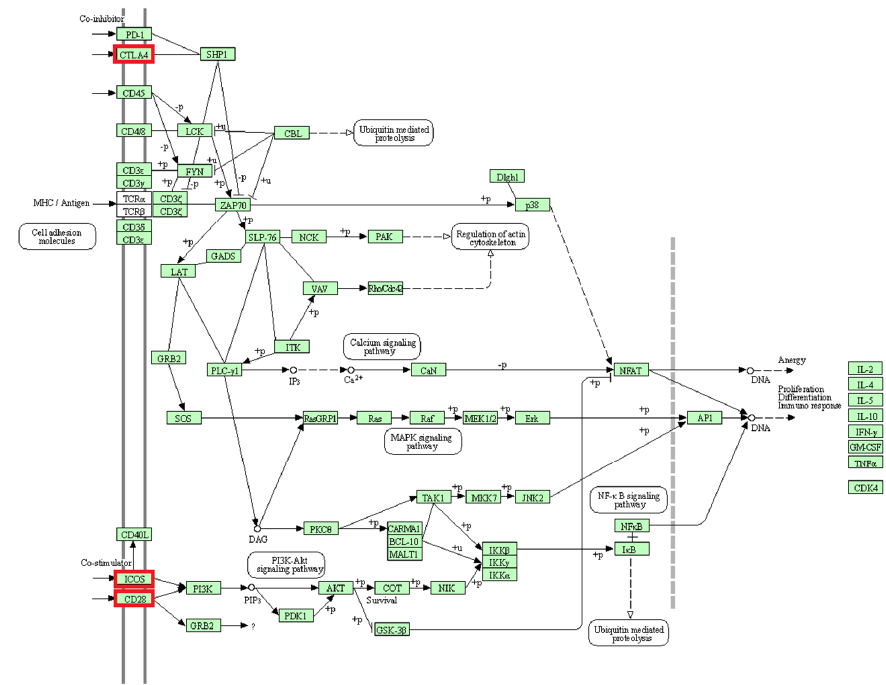
Figure 9. Human T cell receptor signaling pathway (KEGG database [76], hsa04660). The genes belonging to the proteins highlighted in red were identified in selection signals specific for Balusha. All involved proteins are displayed in a light green box.